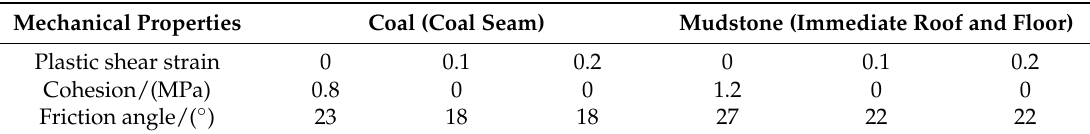
Table 2. Mechanical properties of coal and mudstone with different plastic shear